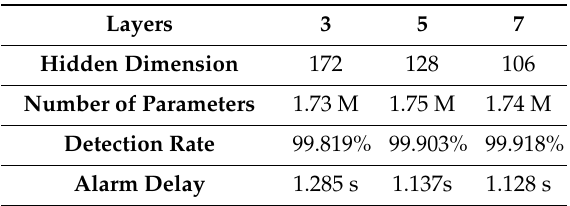
Table 2. Performance with di ff erent hidden